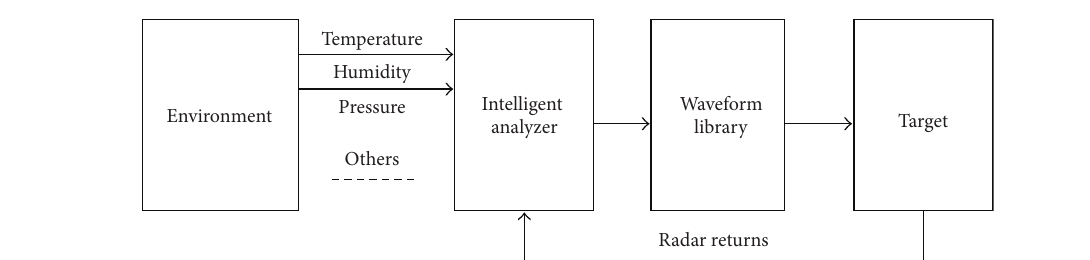
Figure 3: Block diagram of waveform library.